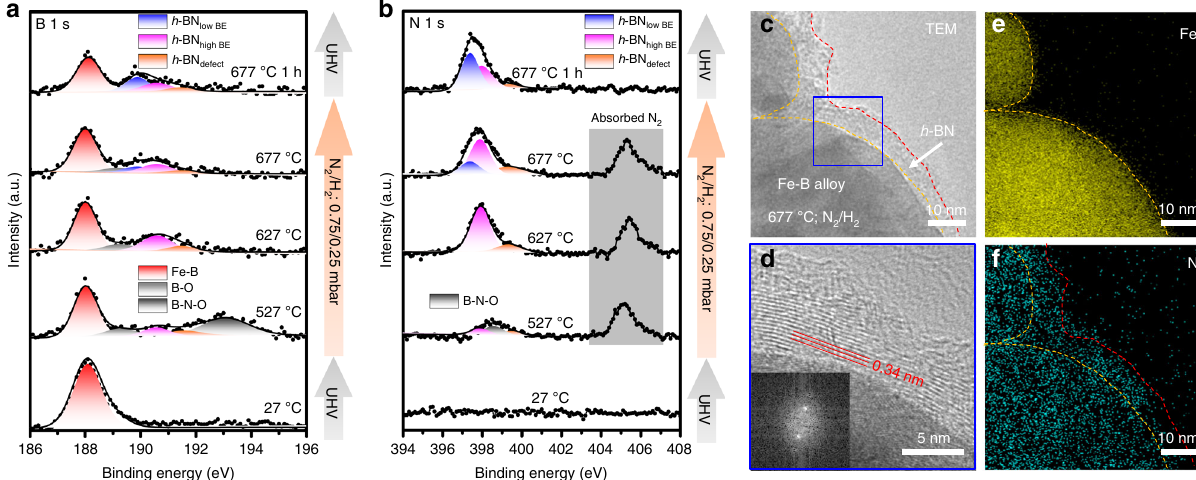
Fig. 4 Investigation of the h -BN growth process on Fe-B alloy. a , b B 1s ( a ) and N 1s ( b ) spectra during the in situ APXPS measurement. c , d TEM images of Fe – B nanoparticles wrapped with layered h -BN. e , f EDS mapping of Fe ( e ) and N ( f ) corresponding to ( circular holes. As shown in Fig. 5b, the OM image of the multilayer h -BN suspended on an array of circular holes indicates high